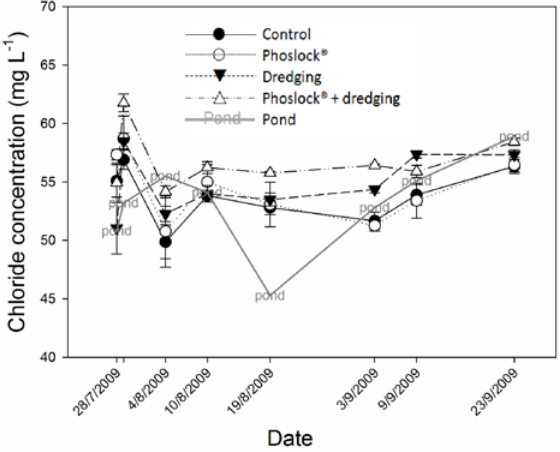
Figure A3. The course of the chloride concentrations (mg L − 1 ) in control enclosures, Phoslock ® -treated enclosures, dredged enclosures, combination Phoslock ® -treated and dredged enclosures, and the pond over the 58-d experimental period in 2009. Error bars indicate one standard deviation ( n = 3).